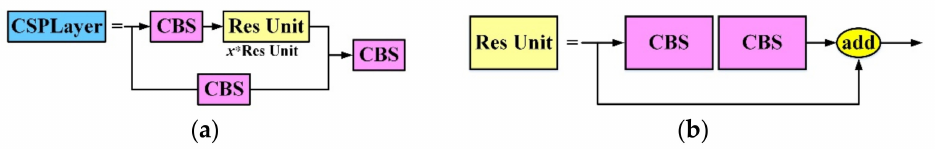
Figure A1. The structure diagram of CSPLayer and Res Unit: ( a ) CSPLayer structure ( b ) Res